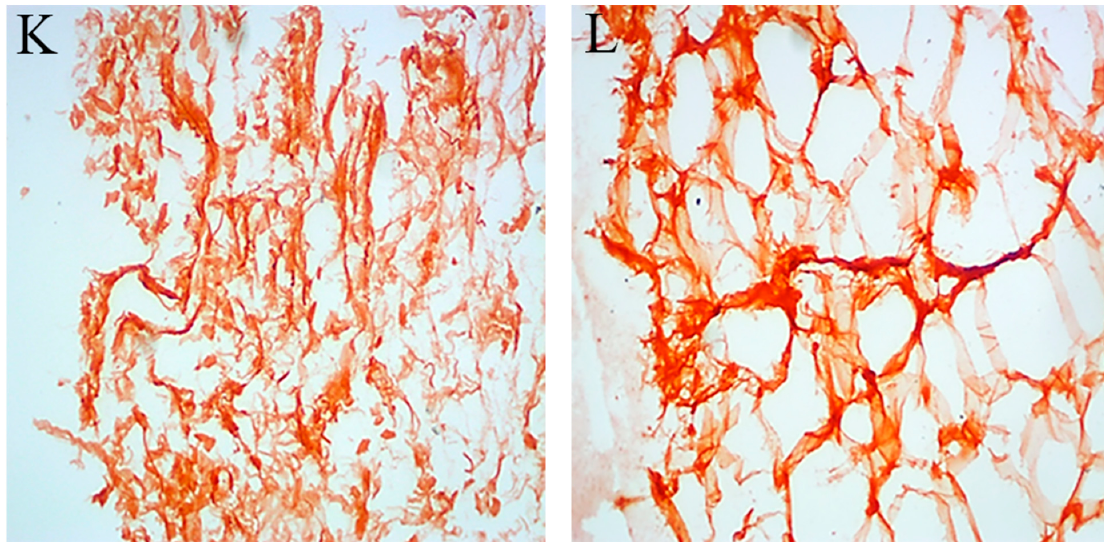
Figure 3. Light microscopic results of excised mass, revealing amyloid fibril deposits by Congo red staining. ( A – L ) are × 40 magnifications, where Sham1 ( A – C ), Sham2 ( D – F ), Exp1 ( G – I ), and Exp2 ( J – L ) are represented. In each group, results of 6, 12, and 18 days of injection are shown from left to right (e.g., A: 6 days, B: 12 days, C: 18 days). Thioflavin is a small molecule with a high affinity for beta structures. It is useful in